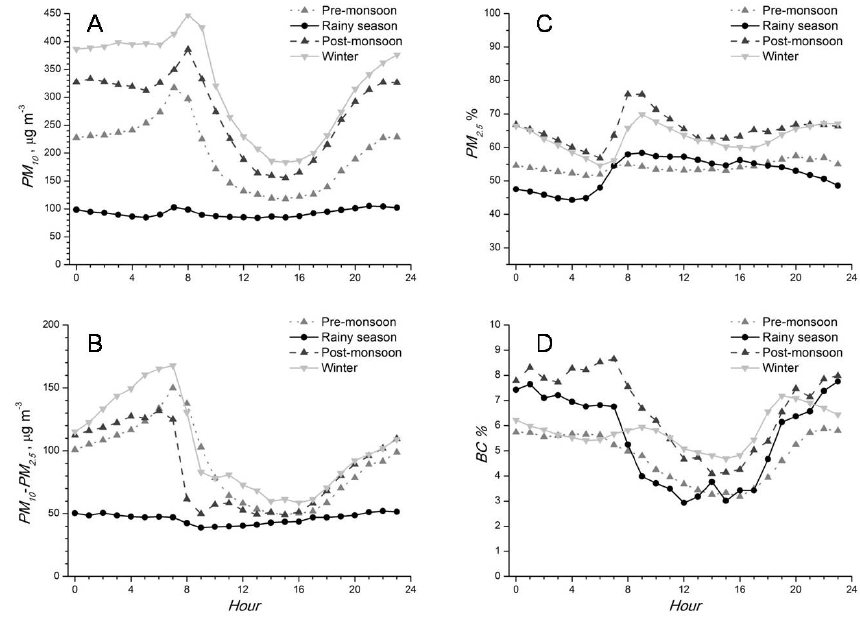
Fig. 9. Diurnal variation of (A) PM 10 , (B) Coarse mode, (C) Percentage of PM 2 . 5 of PM 10 , (D) Percentage of BCe of PM 10